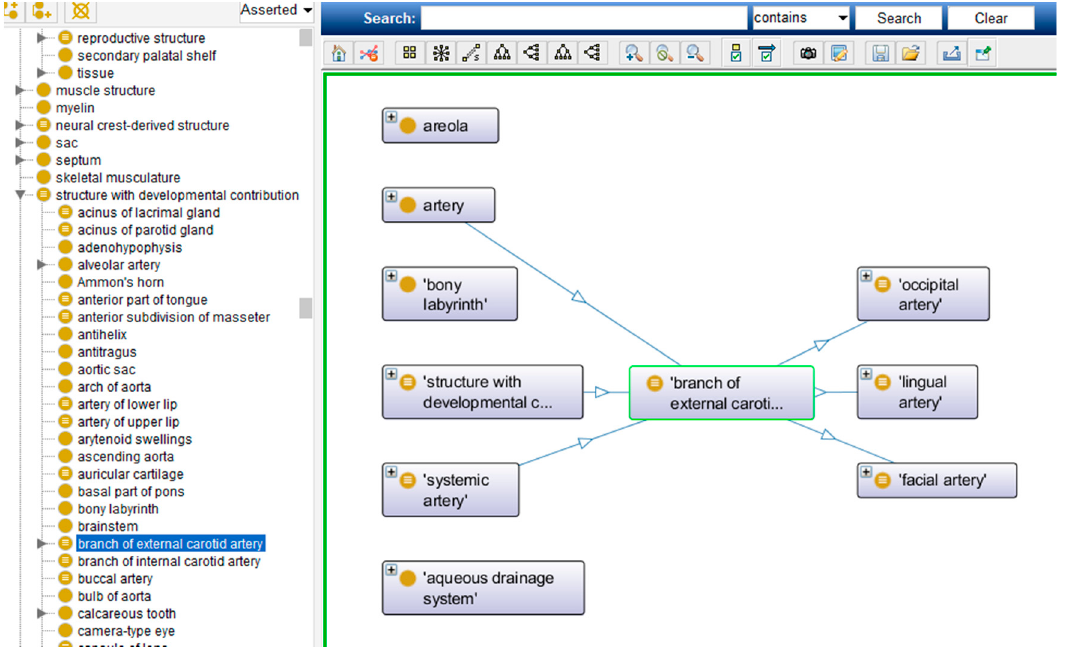
Figure 2. Protégé OntoGraf: List and context subviews loaded with the Human Phenotype Ontology. Source: Image with permission courtesy of Center for Biomedical Informatics Research, Stanford University School of Medicine, Protégé Team, https://protege.stanford.edu.